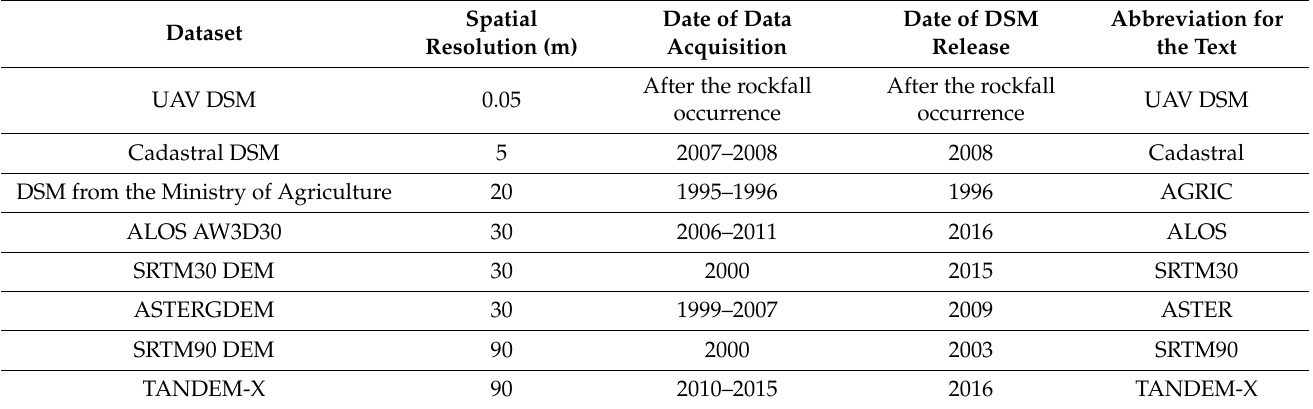
Table 1. Digital surface models used in the current